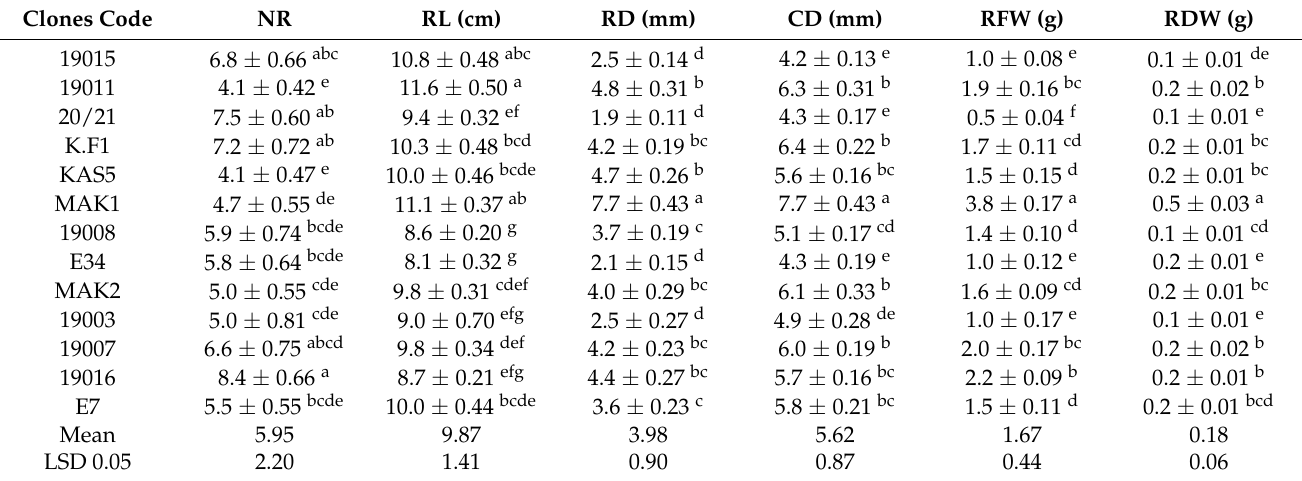
Table 2. Number of roots per plant, root length, root diameter, collar diameter, and root biomass of elite Melia volkensii clones seedling after two months under acclimatization.